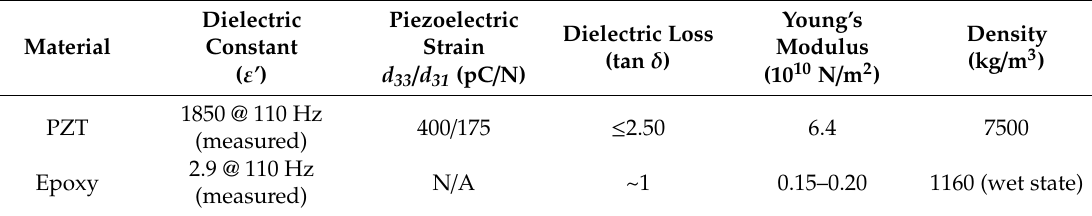
Table 2. Overview of the piezoelectric, dielectric, and physical properties of lead zirconate titanate (PZT) and